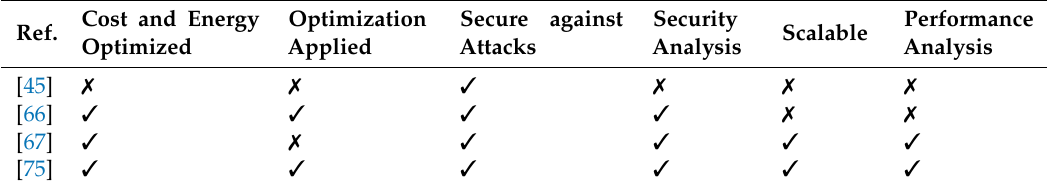
Figure 11. Architecture for secure equipment maintenance. Table 5. Comparison of state-of-the-art research papers on equipment maintenance and monitoring in smart grids using